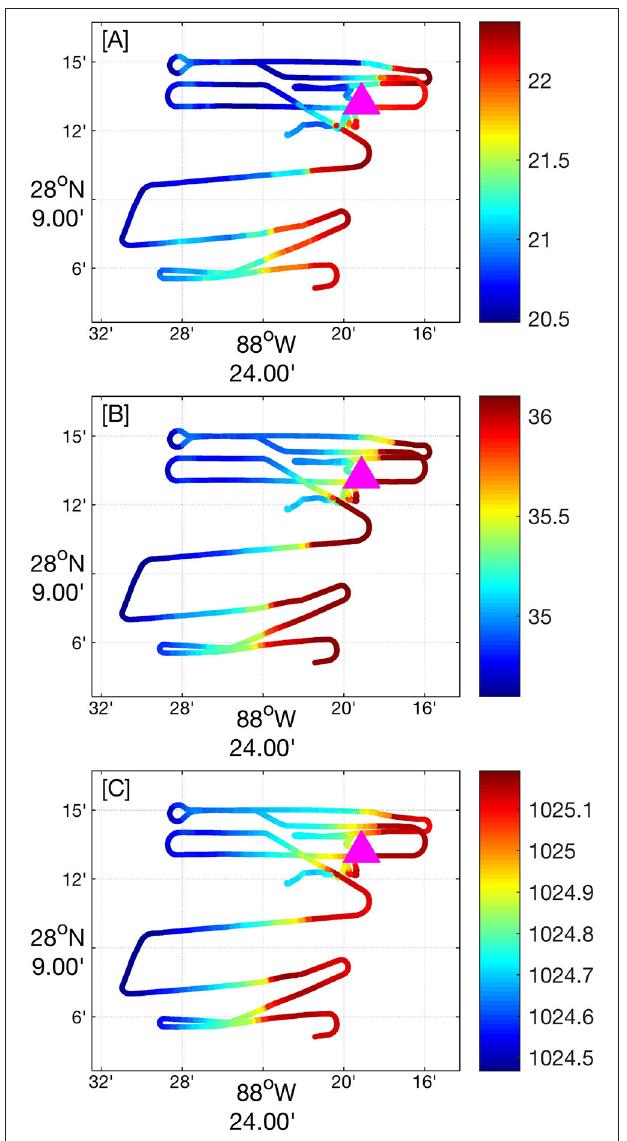
FIGURE 7 | Sea surface temperature (A) , salinity (B) , and density (C) recorded by the thermosalinograph on the R/V Walton Smith. The starting location of the STARSS dispersion experiment is indicated by the pink triangle.